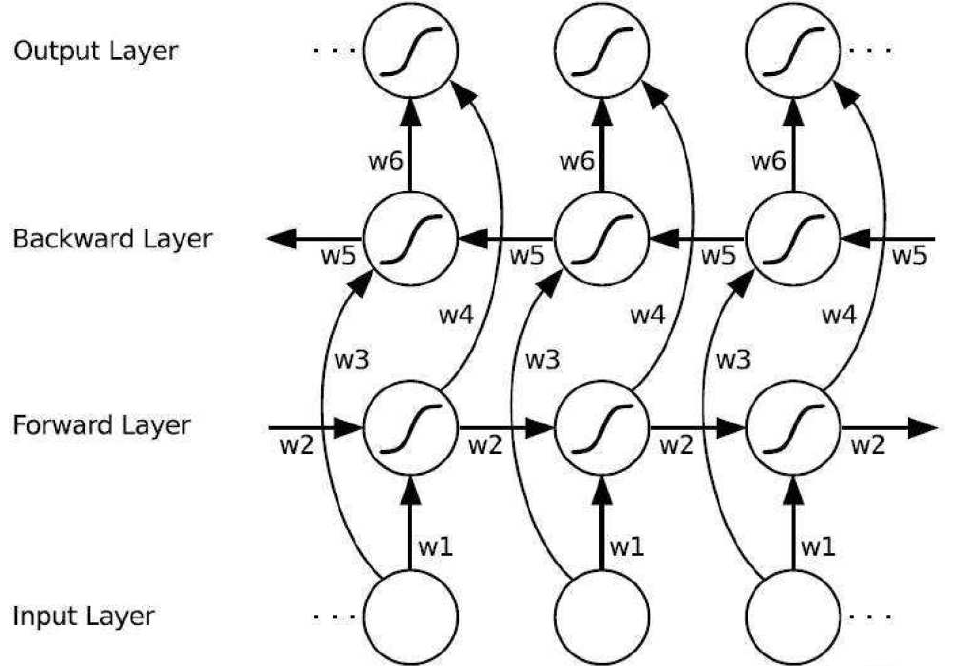
Fig. 6 Bi-LSTM model